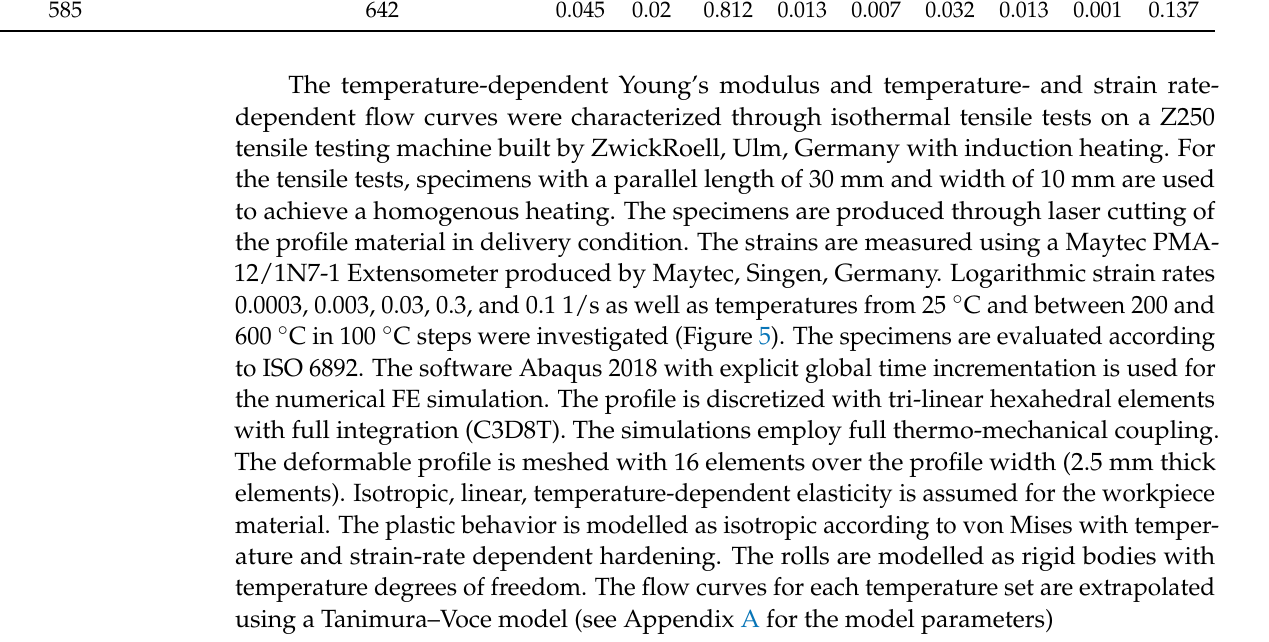
Table 2. Mechanical properties and chemical composition of steel S500MC in delivery condition according to EN 10140-2. Yield Strength R p 0 , 2 in